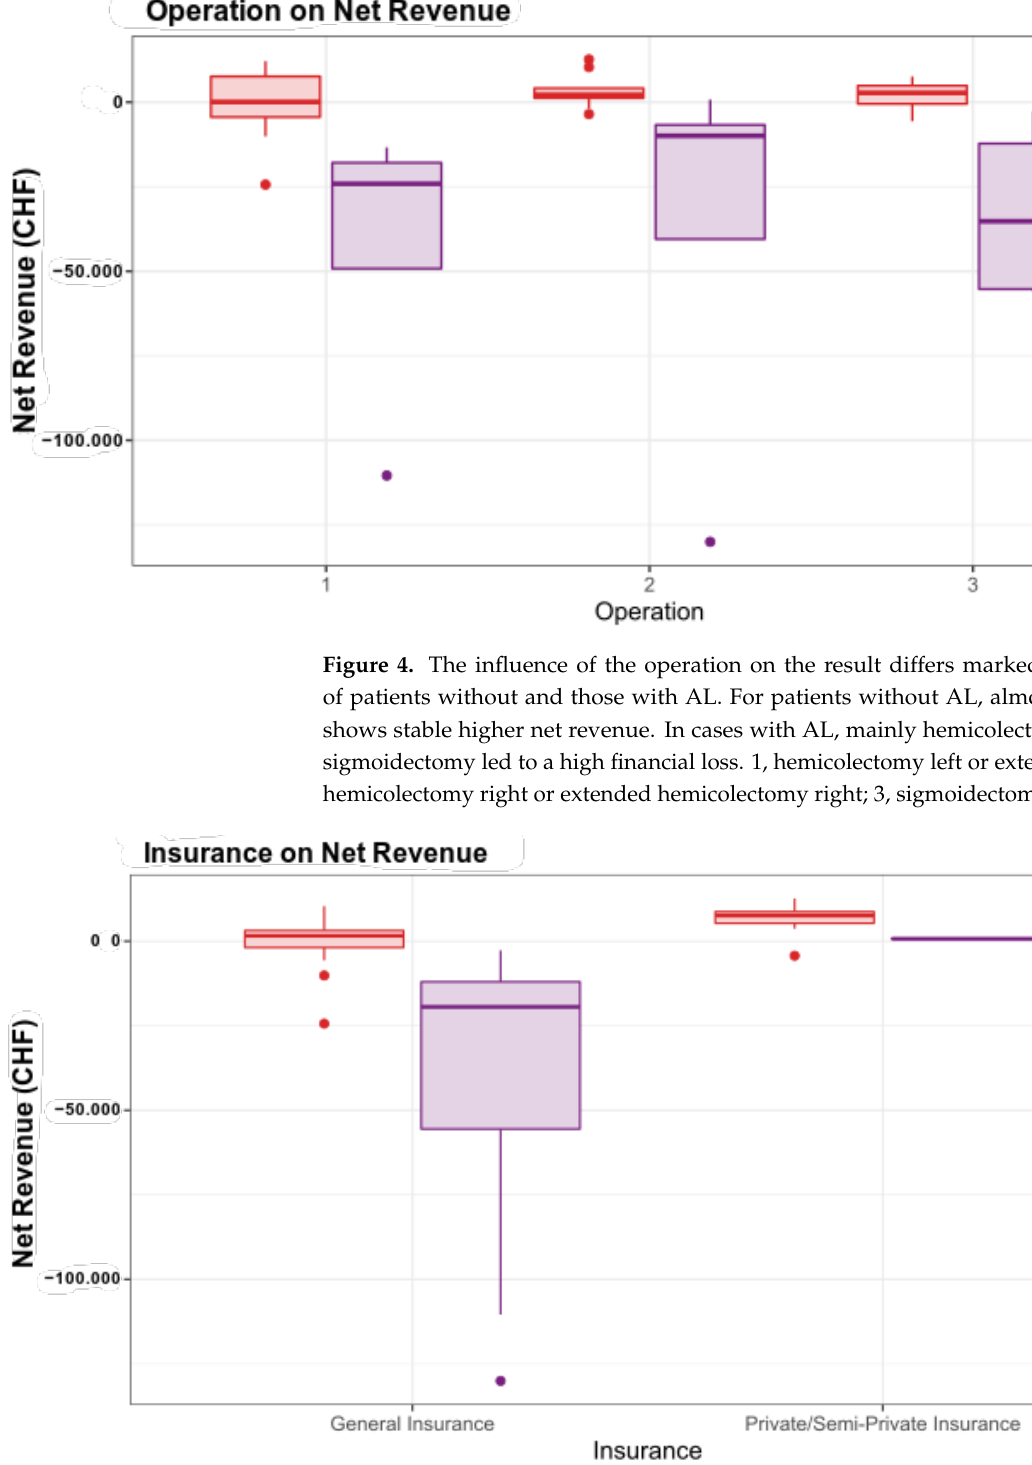
Figure 5. The type of health insurance policy (general insurance vs. semi-private/private insurance) determines the impact of an AL on the net revenue. If no AL occurs, the type of insurance has a minor influence on the net revenue compared to patients with AL. If an AL occurs, losses are ex- pected mainly for general insured patients